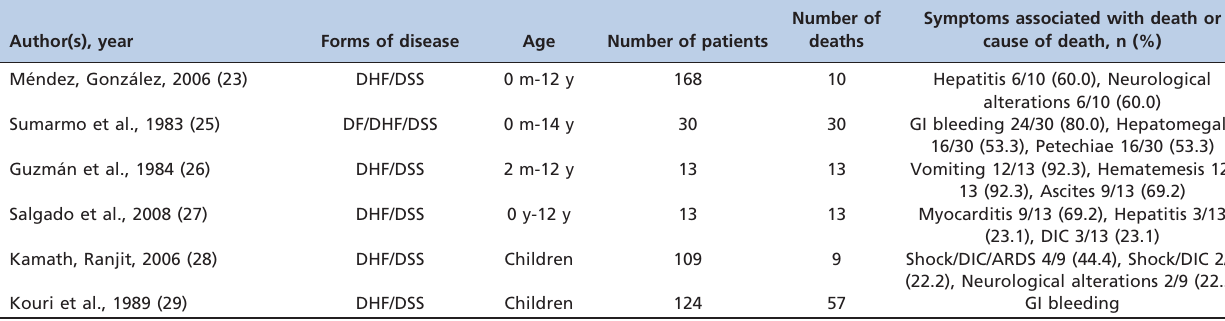
Table 5 - Summary of descriptive studies on dengue deaths in